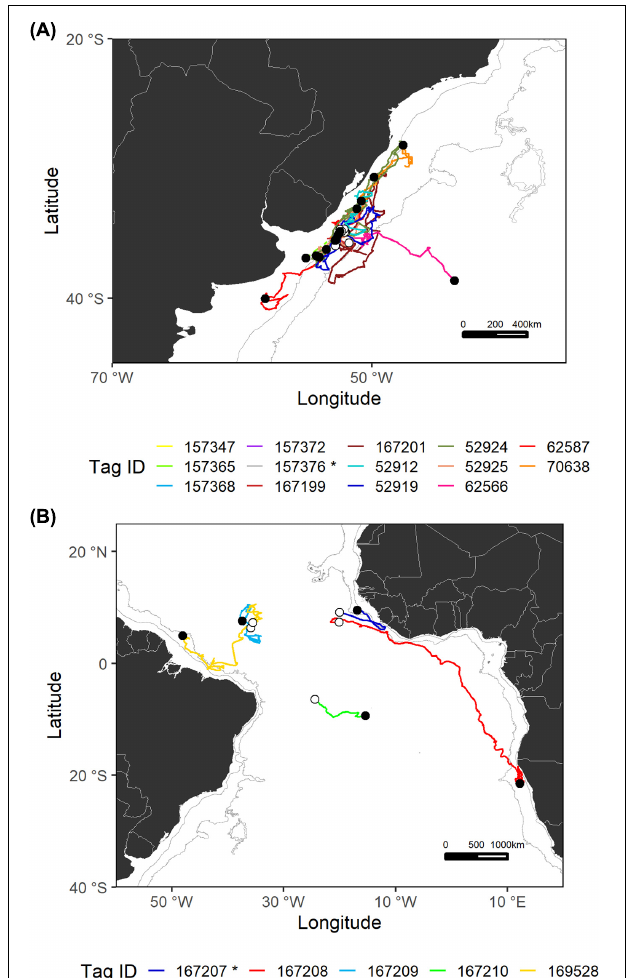
FIGURE 3 | Estimated most likely tracks for each shortfin mako tagged in the Southwest Atlantic (A) and Central Atlantic (B) regions. The tagging locations are represented with open circles and the pop-up locations with black circles. The asterisk (*) in the legend indicates mature sharks. Note that for sPATs only straight line tracks are shown (dashed lines). Gray lines represent the boundaries of continental and insular margins (140–3,500 m